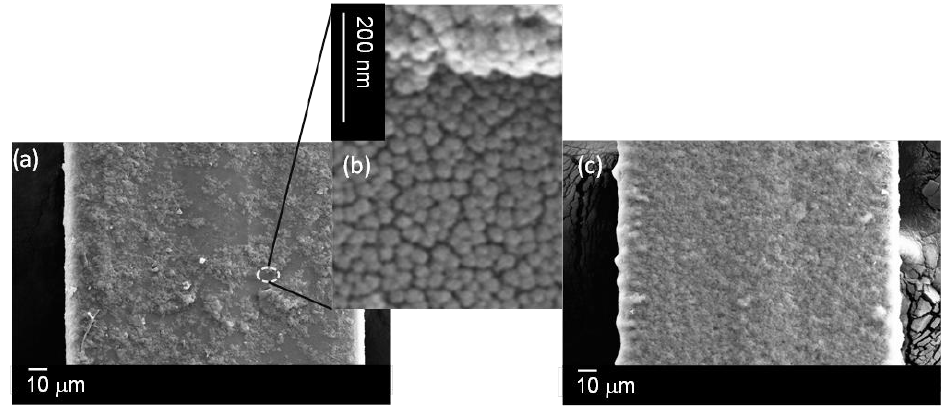
Figure 5. SEM images of ( a ) Sample 2 and inset ( b ) of Sample 2 showing the assembled layer below aggregated regions; and ( c ) Sample 3.